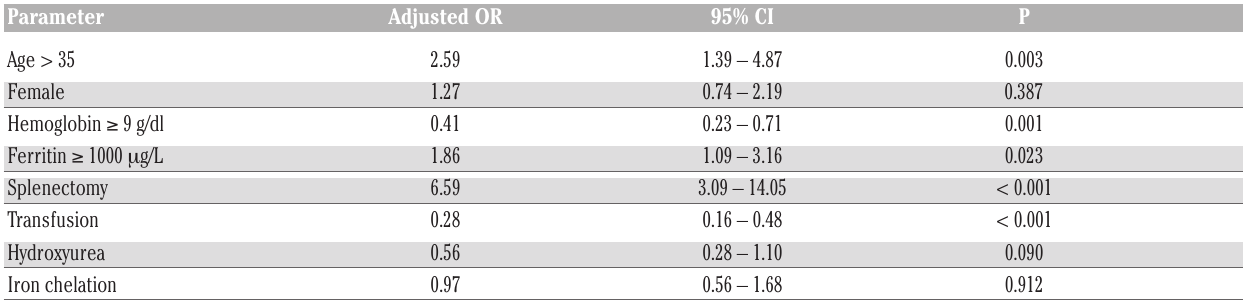
Table 2. Predictors of thrombosis in the OPTIMAL CARE study. 12